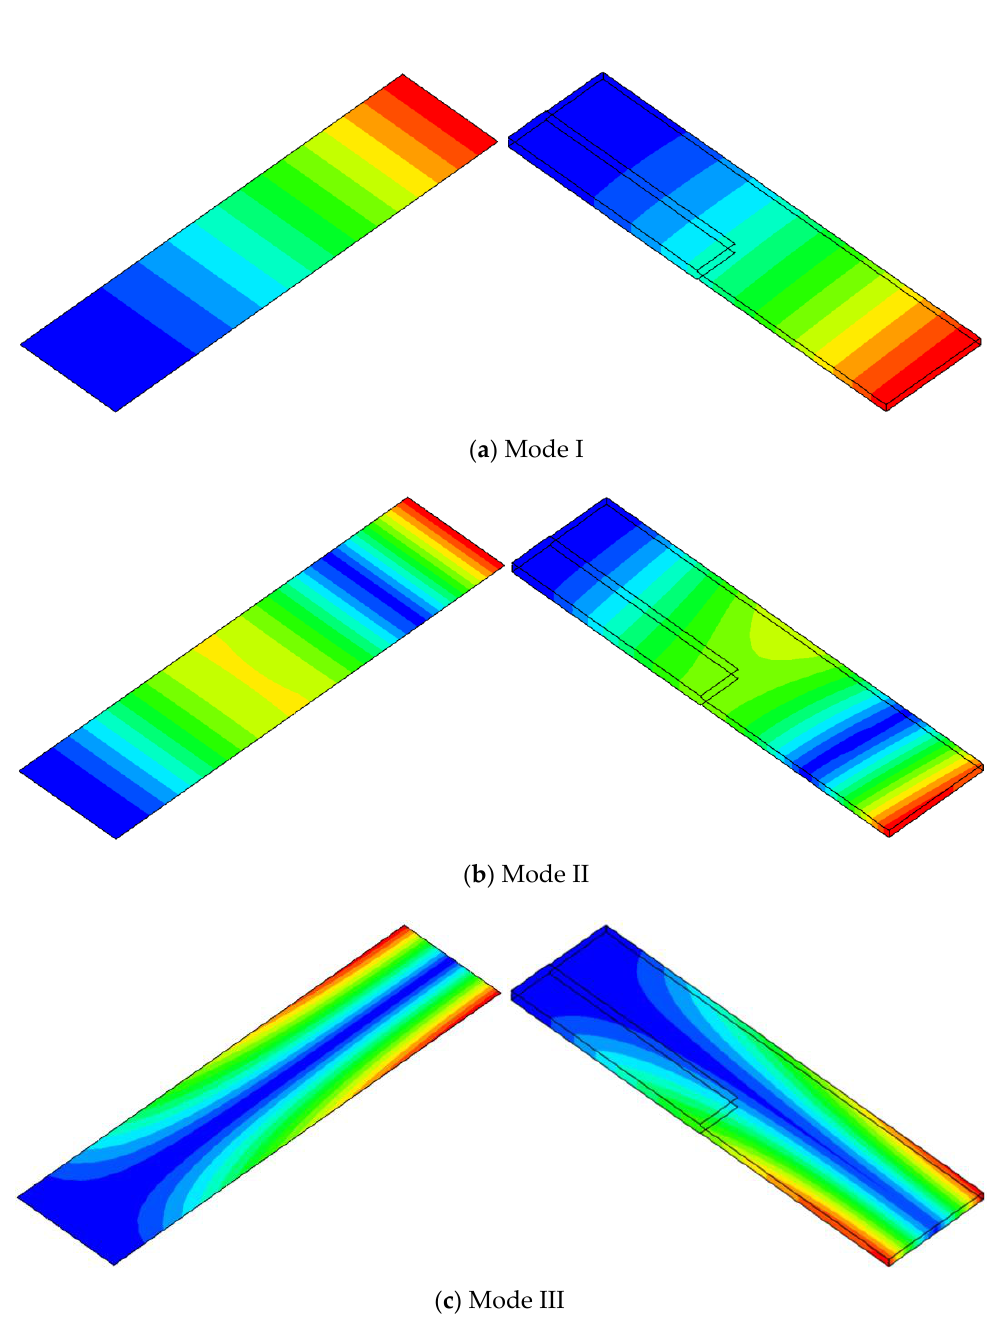
Figure12. Mode shapes of the unreinforced and reinforced plates ( θ = 0, L x / L y = 4, FFFC plate).